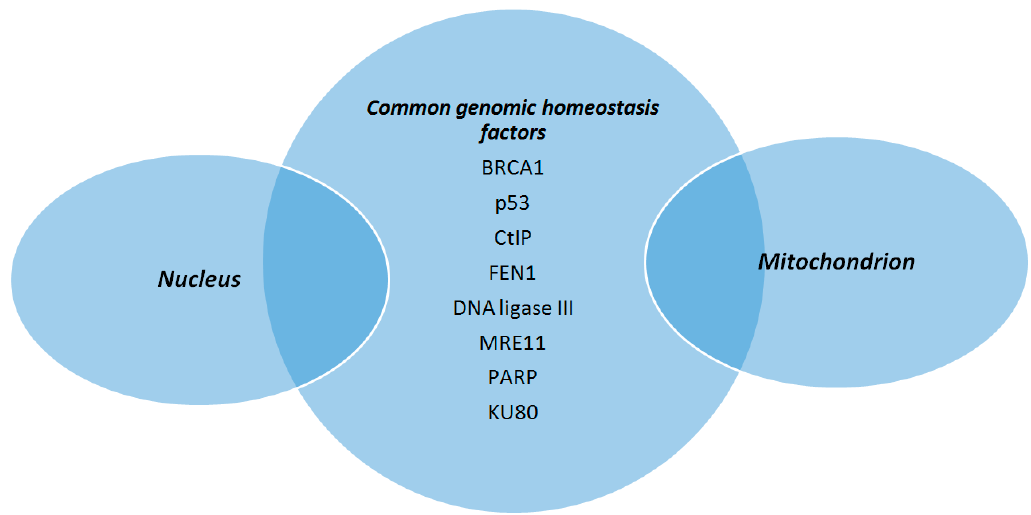
Figure 4. Proteins involved in the maintenance of mitochondrial DNA integrity, in addition to their role in ensuring nuclear genomic homeostasis. (BRCA1: breast cancer type 1 protein, CtIP: CtBP-interacting protein, FEN1: flap endonuclease 1, MRE11: meiotic recombination 11, PARP: poly (ADP-ribose) polymerase).